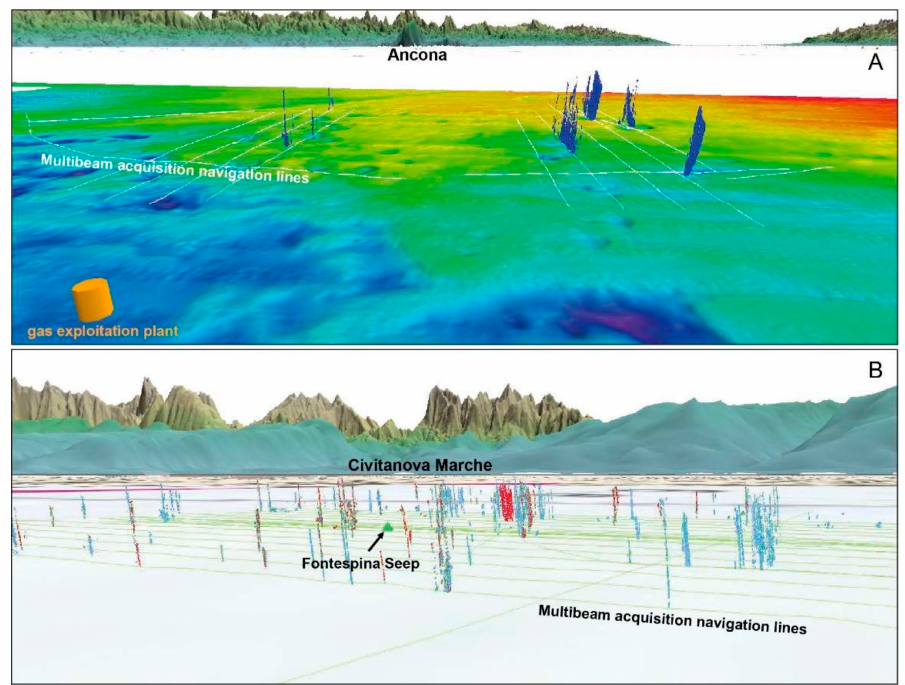
Figure 5. 3D visualization (Fledermaus scene) of processed gas plumes in the water column at the Fontespina site ( A ) and Bonaccia site ( B ). Each point’s colour may variably represent plumes’ height in the water column, amplitude or number of